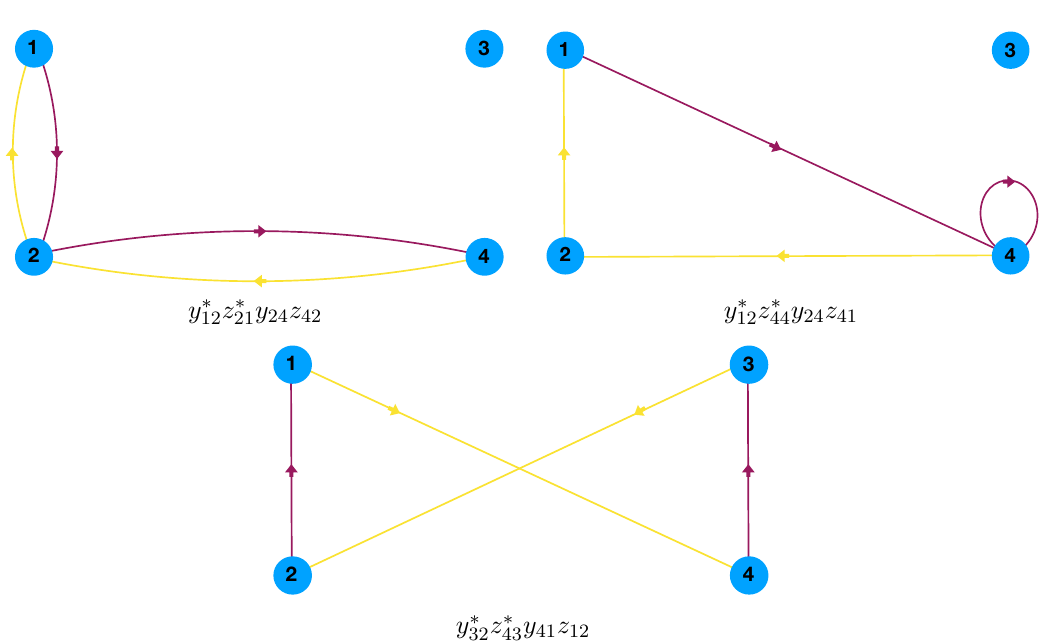
Figure 2. Open string configurations for typical plaquette producing terms in equation (3.21). The Y string are shown in yellow and the Z strings in